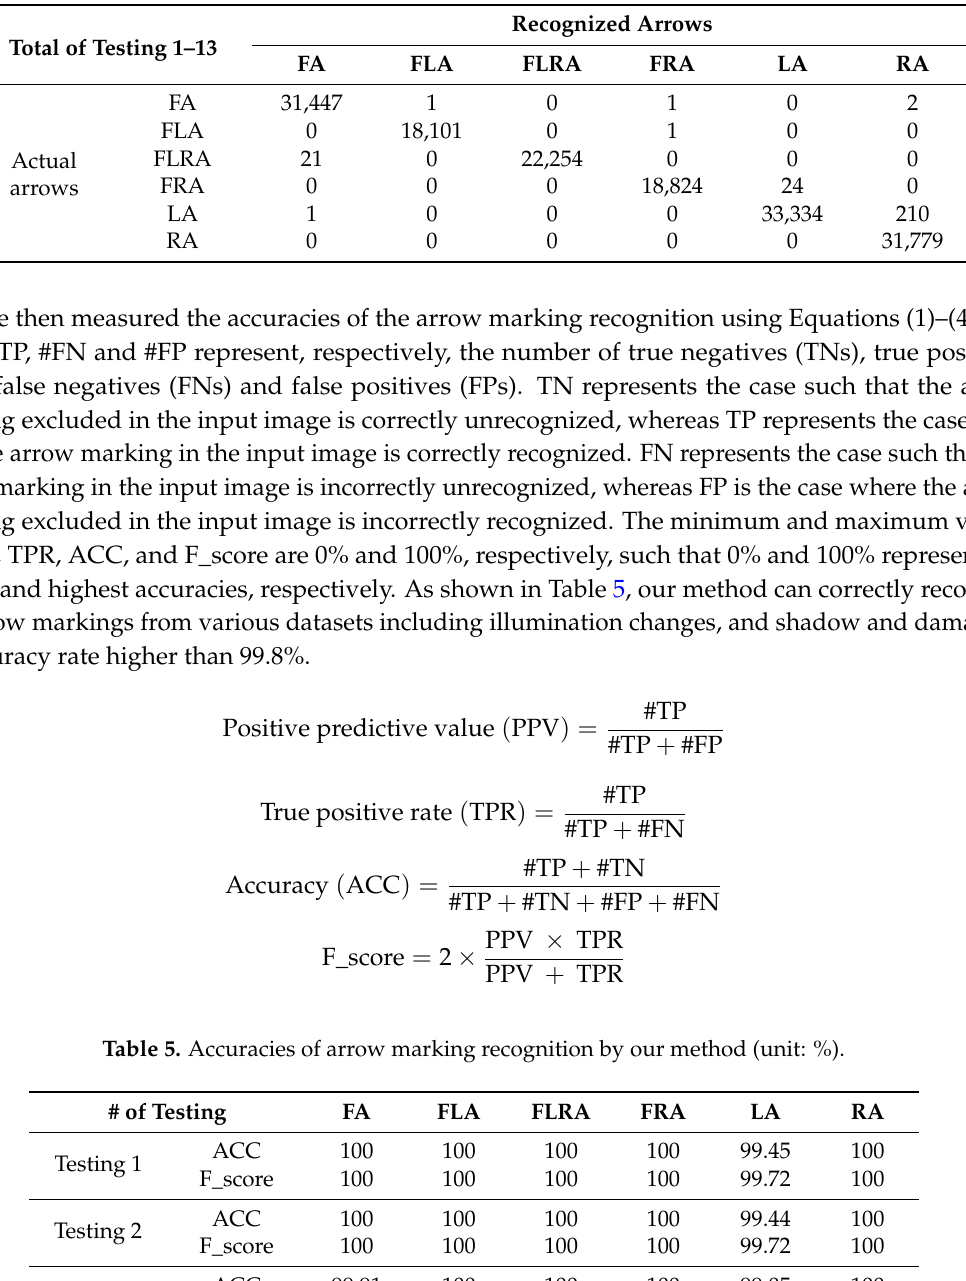
Table 4. The summated confusion matrix of tests 1–13.